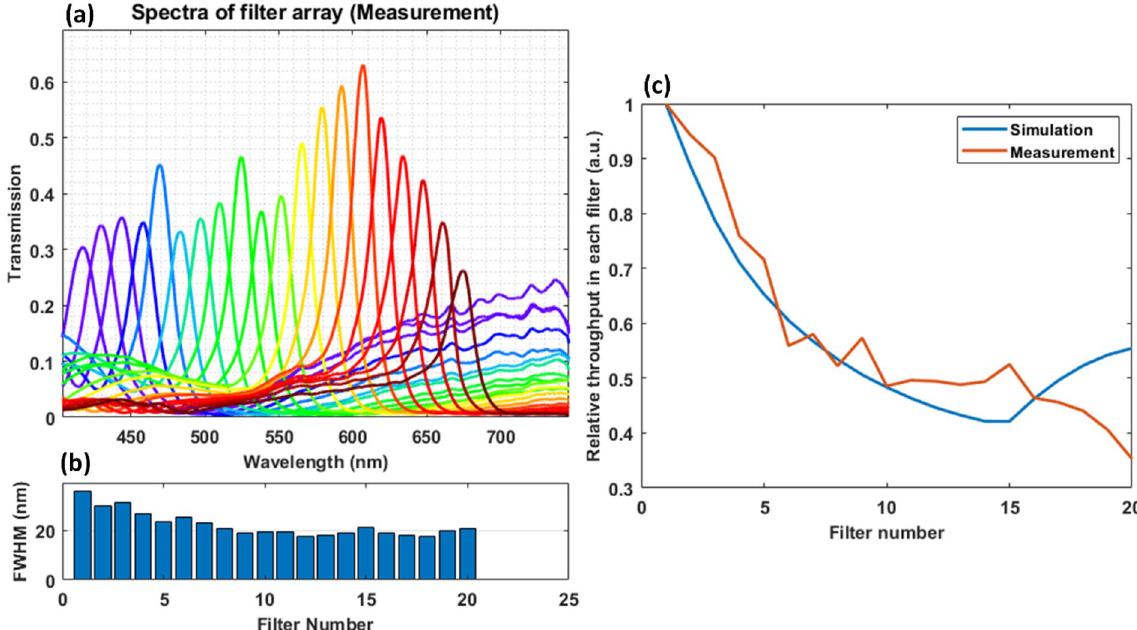
Figure 4. ( a ) Measured filter array spectra, ( b ) FWHM of each filter, and ( c ) relative throughput in each filter comparison between simulated spectra and measured